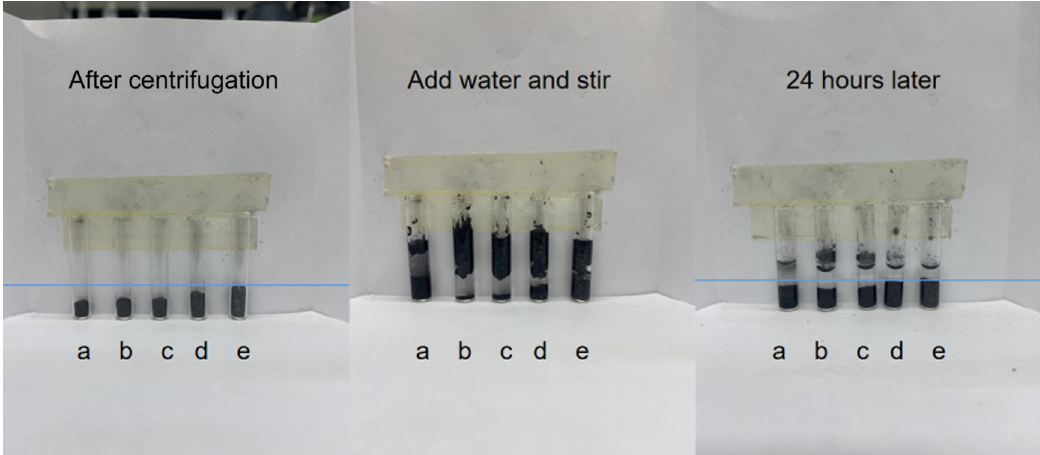
Figure 5: Swelling quantity of the carbon solid acid catalysts prepared with di ff erent mass ratios of raw materials. ( a ) G/F - 1/4, ( b ) G/F - 1/3, ( c ) G/F - 1/2, ( d ) G/F - 1/1, and ( e ) G/F - 1/0.5.